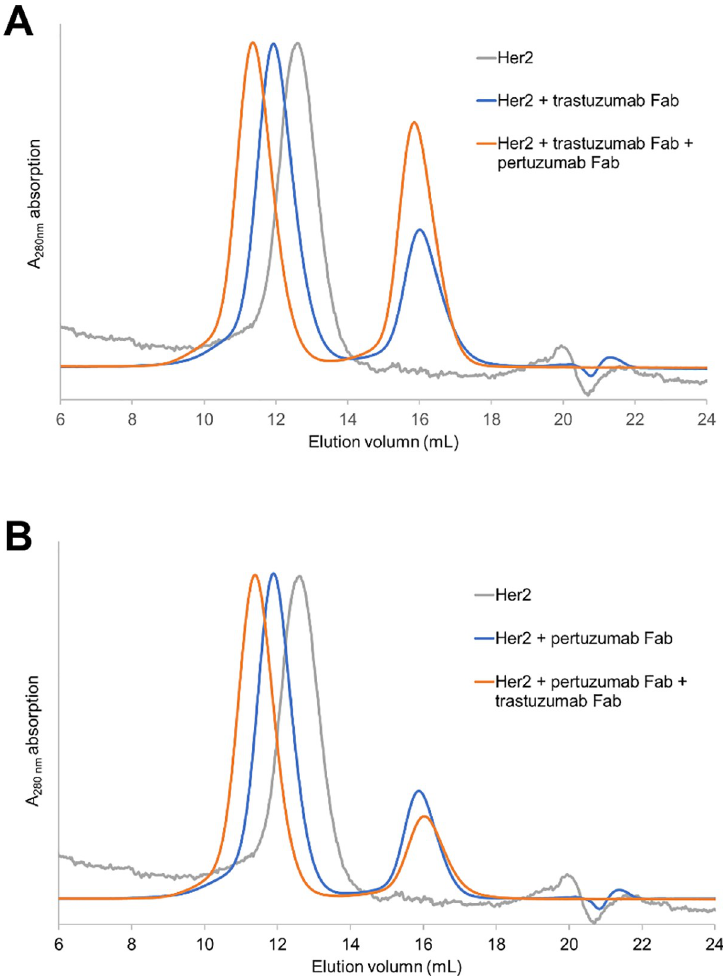
Fig 1. SEC profiles showing the formation of HER2-trastuzumab-pertuzumab ternary complex. A. HER2 is first complexed with trastuzumab Fab and the binary complex elutes earlier than HER2 alone. The purified complex is further complexed with pertuzumab Fab and the ternary complex elutes earlier than the binary complex. The UV absorption is normalized. B. HER2 is first complexed with pertuzumab Fab and the binary complex elutes earlier than HER2 alone. The purified complex is further complexed with trastuzumab Fab and the ternary complex elutes earlier than the dimer. The UV absorption is normalized. and HER2-trastuzumab (RMSD of 1.33 Å over 542 C α atoms, Fig 4C). HER2 in the ternary complex adopts the same conformation as in the binary complexes and apo.[12, 13] Pertuzu- mab Fab in HER2-trastuzumab-pertuzumab aligns well with that in HER2-pertuzumab including the constant region (Fig 4B). In comparison, the variable region of trastuzumab Fab in HER2-trastuzumab-pertuzumab superimposes well with that in HER2-trastuzumab while its constant region is shifted from that in HER2-trastuzumab (Fig 4C). This is likely because the trastuzumab Fab, particularly its constant region, in the HER2-trastuzumab structure is involved in extensive crystal contacts whereas the pertuzumab Fab in the HER2-pertuzumab structure is not.[12, 13] Importantly, the interactions between HER2 and the two Fabs are very similar among the ternary and binary complexes[12, 13] with pertuzumab and trastuzumab Fabs bound to domains II and IV of HER2 respectively. Comparison of the cryo-EM structure of HER2-trastuzumab-pertuzumab with the crystal structures of HER2-pertuzumab and